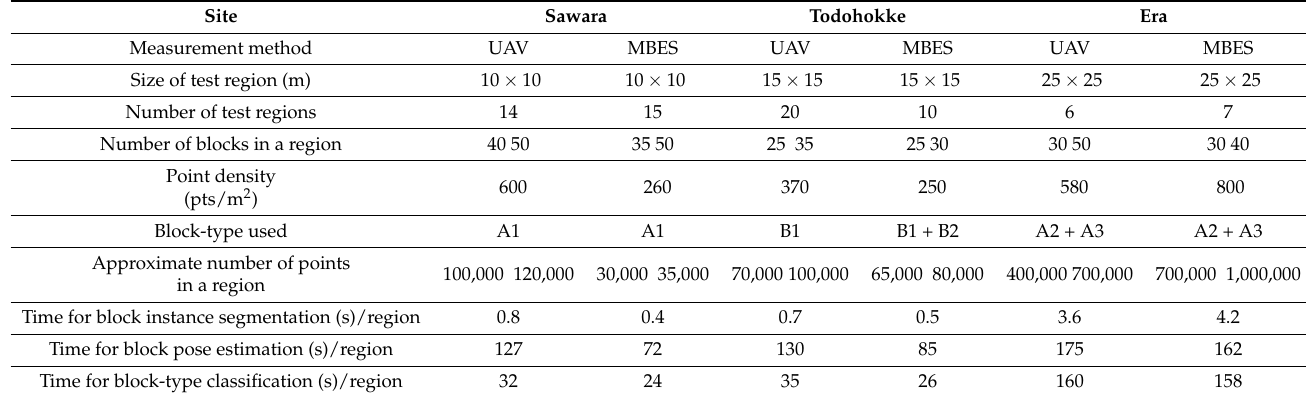
Table 8. Processing time for block